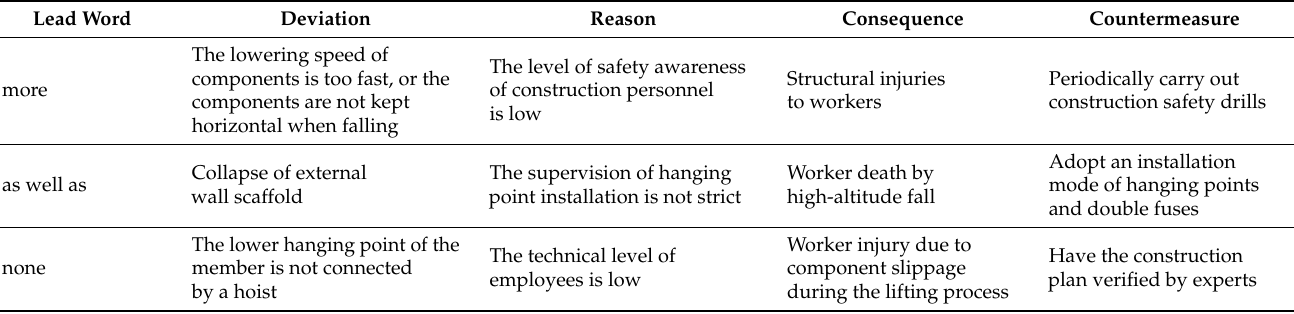
Table 10. HAZOP analysis of the component installation